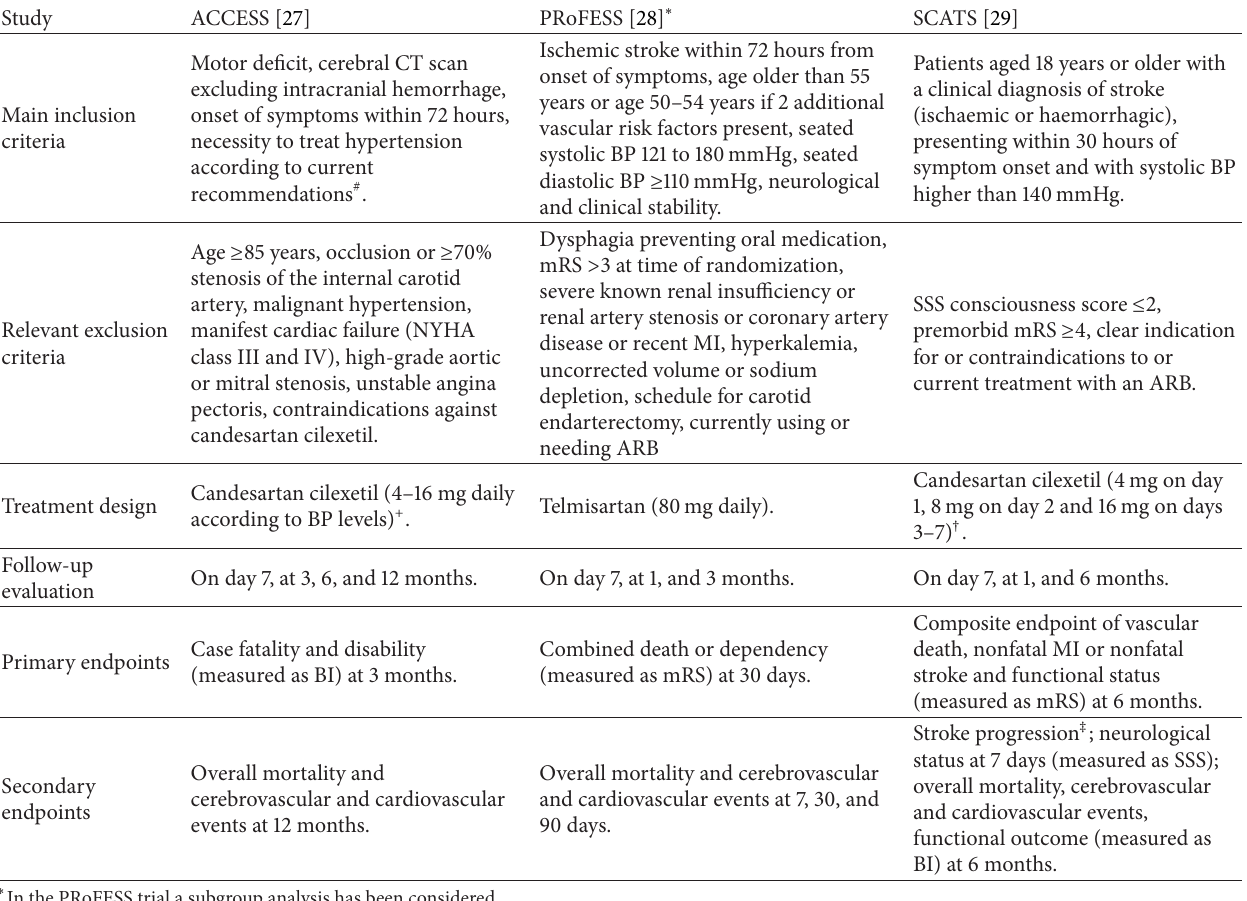
Table 2: Main characteristics of the included